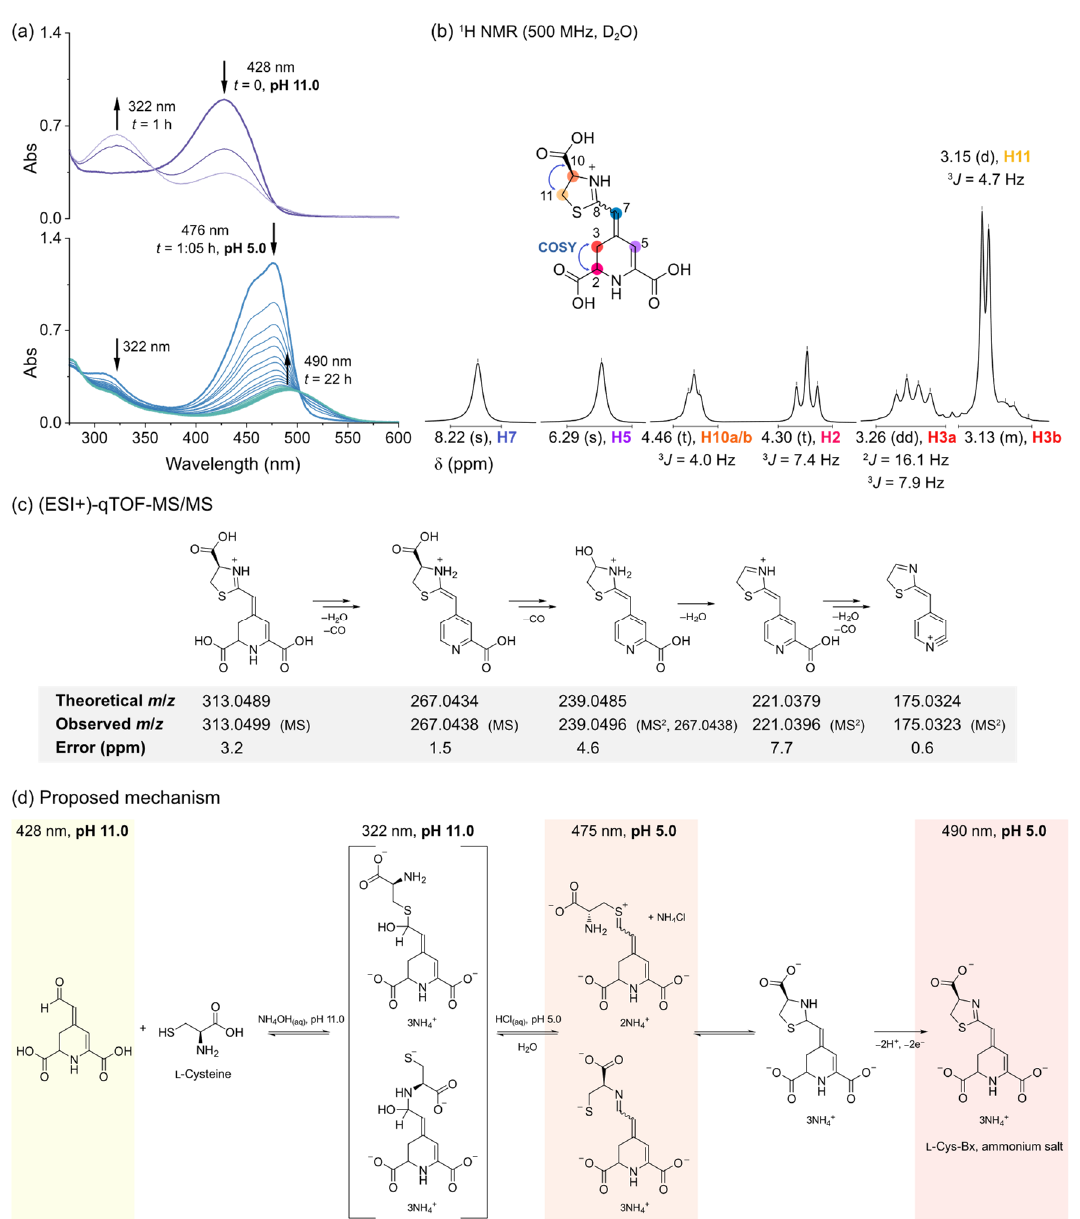
Figure 2. Characterization of Cys-Bx. ( a ) UV-Vis absorption spectra over time. ( b ) 1 H NMR analysis. Blue arrowed curves indicate couplings found in 1 H, 1 H COSY analysis (Figure S27). ( c ) Mass fragmentation pattern of Cys-Bx; raw MS data are presented in Figure S6. ( d ) Proposed mechanism for the formation of Cys-Bx in